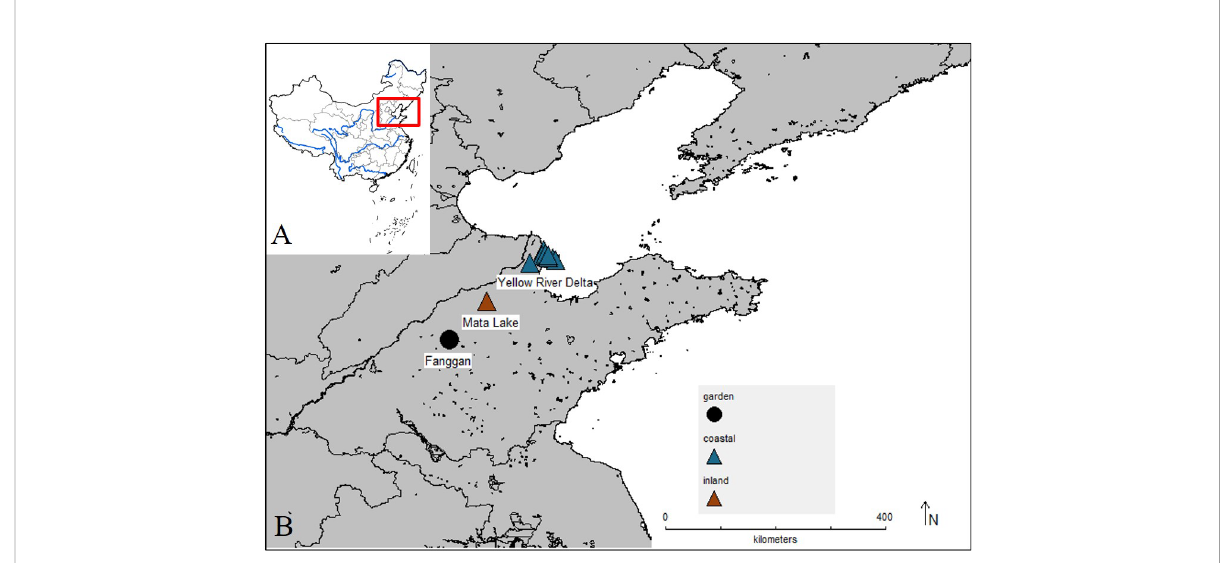
FIGURE 1 Map of China (A) highlighting the location of the inland and coastal wetland populations of Phragmites australis (B) collected and used in our experiment and the location of common garden